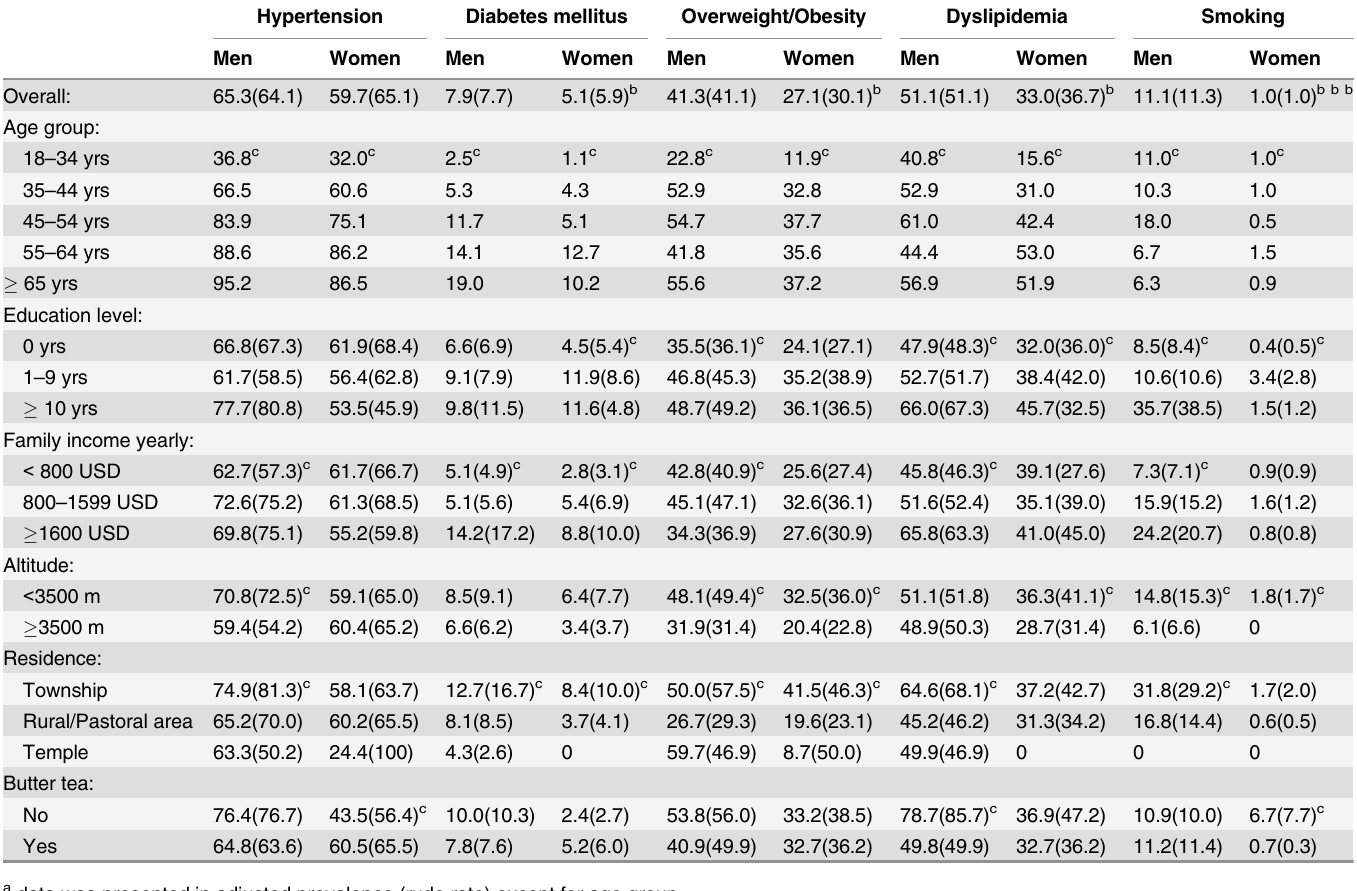
Table 3. The age adjusted prevalence of CVD risk factors by demographic characteristics among Tibetan by gender.